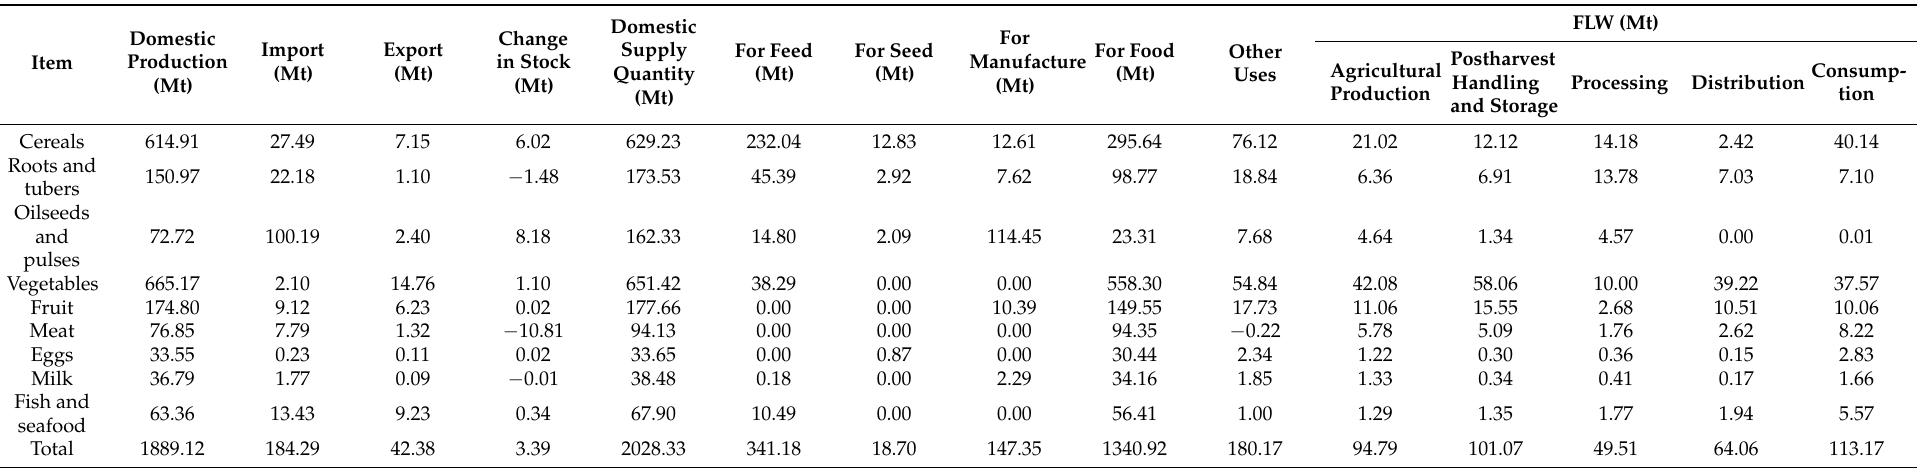
Table 1. Food balance of China in 2019 and the calculation of